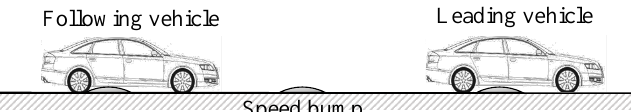
Figure 6. The bumpy road environment for forward collision avoidance, adaptive cruise, or